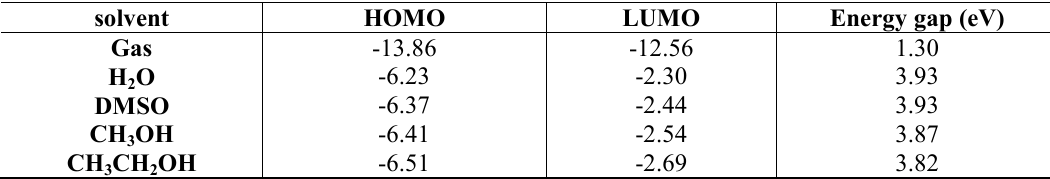
Table 5. HOMO and LUMO energies and their energy gaps for V isomer at the BLYP/6- 311G** level in different